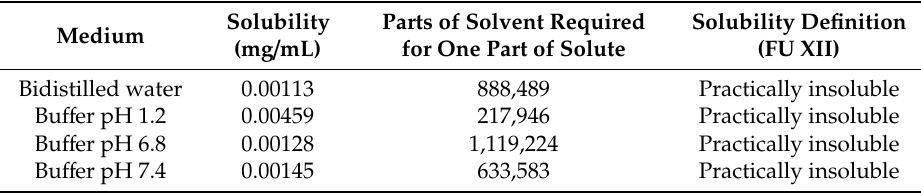
Table 3. Solubility of SS13 obtained in di ff erent